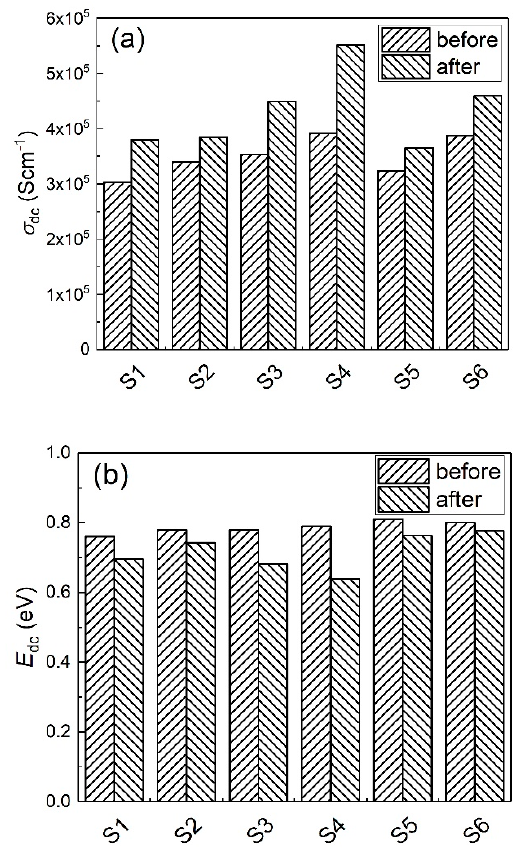
Figure 6. DC conductivities ( a ) and their activation energies ( b ) of S1–S6 before and after DC aging.